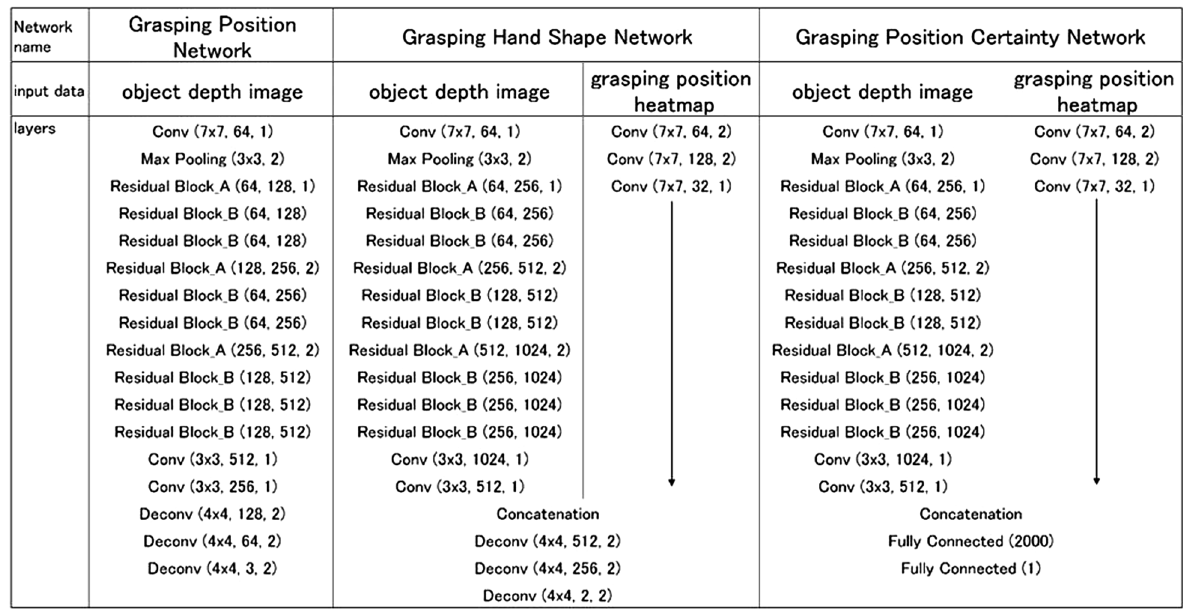
Table 1 Details of the structure of each network